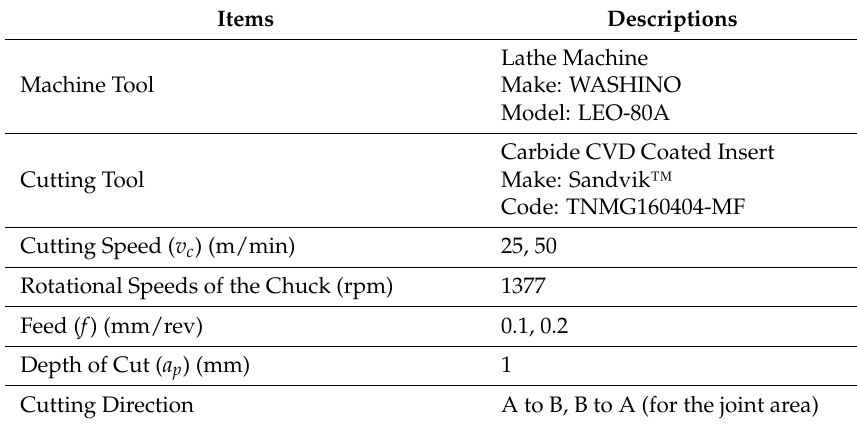
Table 3. Cutting conditions for machining